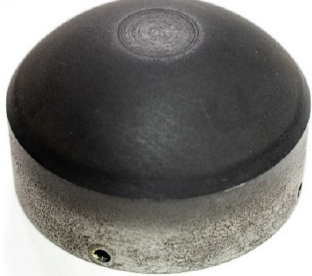
Figure 19. Sample machined.